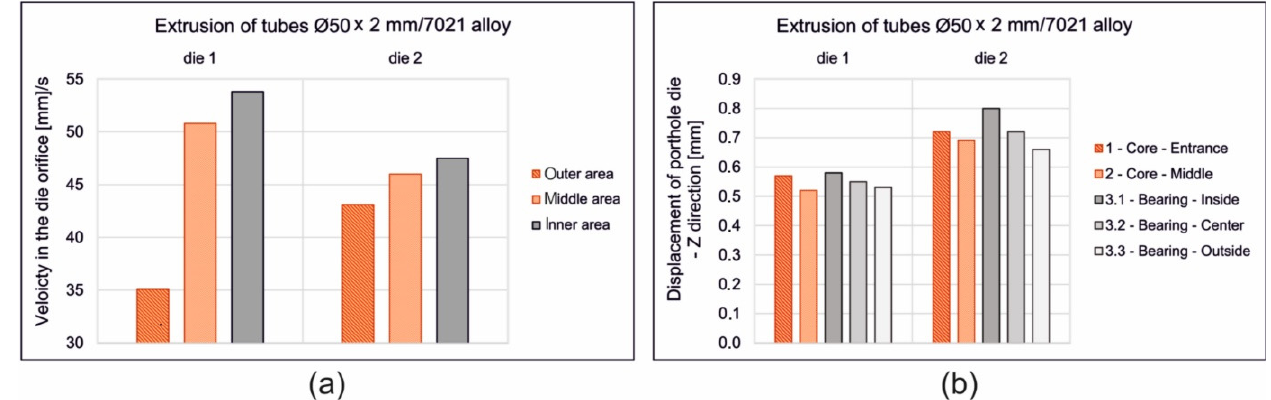
Figure 10. Diagrams of the metal velocity in the die cavity during extrusion of tubes of Ø50 × 2 mm from 7021 aluminium alloy through porthole dies of different geometry ( a ) and porthole die deflection in Z direction in different areas of mandrel for different die geometry ( b